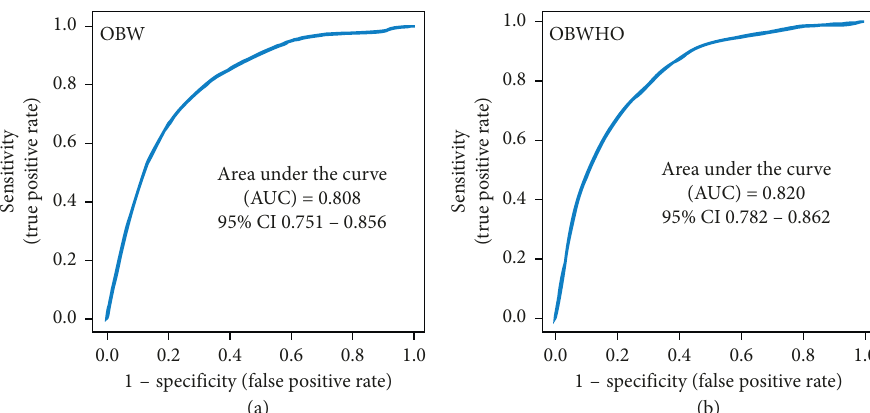
Figure 2: ROC analysis for classification performance using a subset of top-ranking variables from the aggregated rank list. The smooth ROC was averaged from 100 bootstrap samples, which provided the bootstrap percentile confidence interval. Support vector machine (SVM) was used as the classifier for obesity as defined by (a) waist circumference (OBW) and (b) BMI (OBWHO).